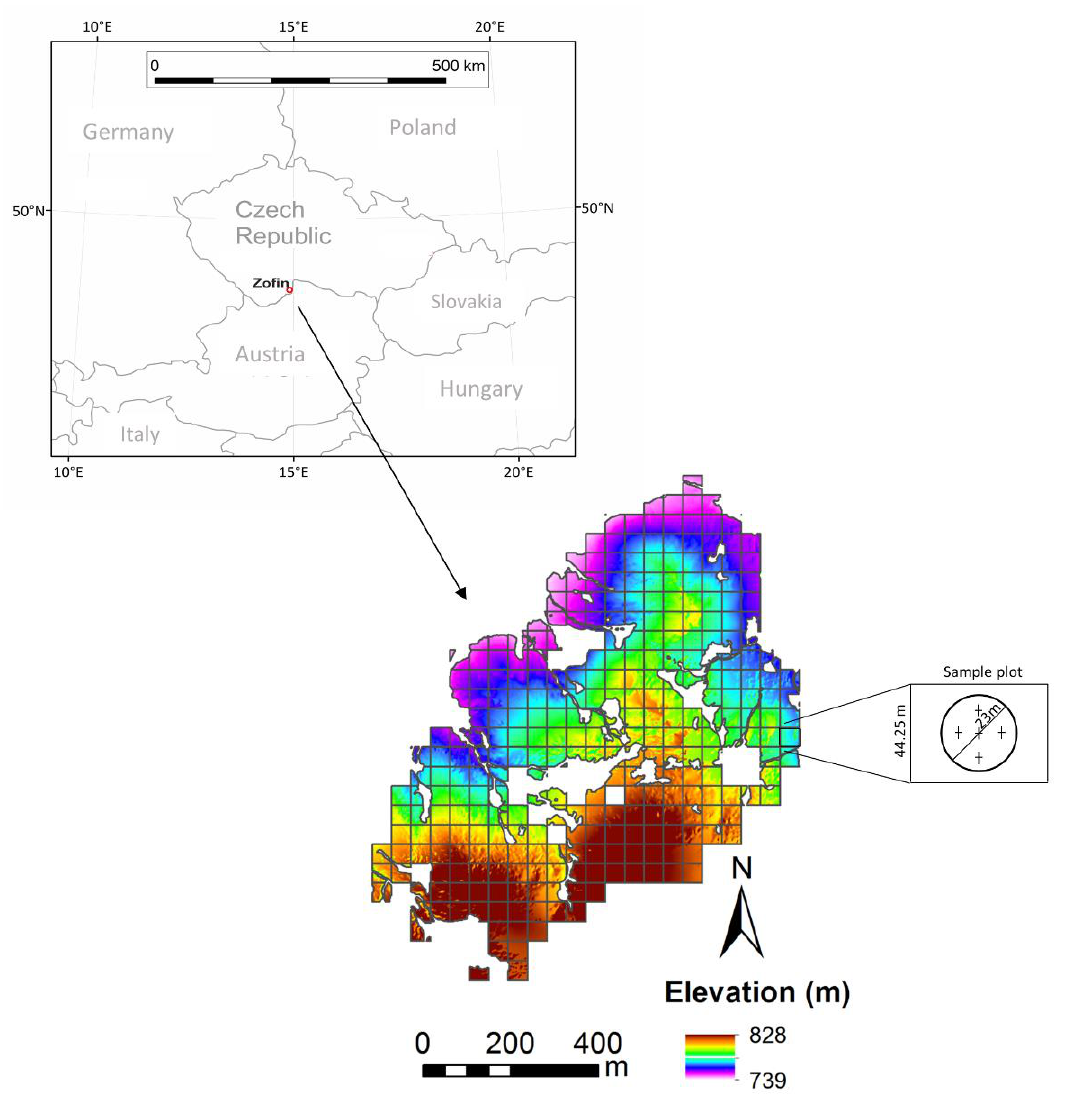
Figure 1. Location and elevation of the study area, and the sampling methodology. The black dots are the location of four soil profiles randomly selected in the study area. White areas represent soils with hydromorphic characteristics that were not considered in this study.